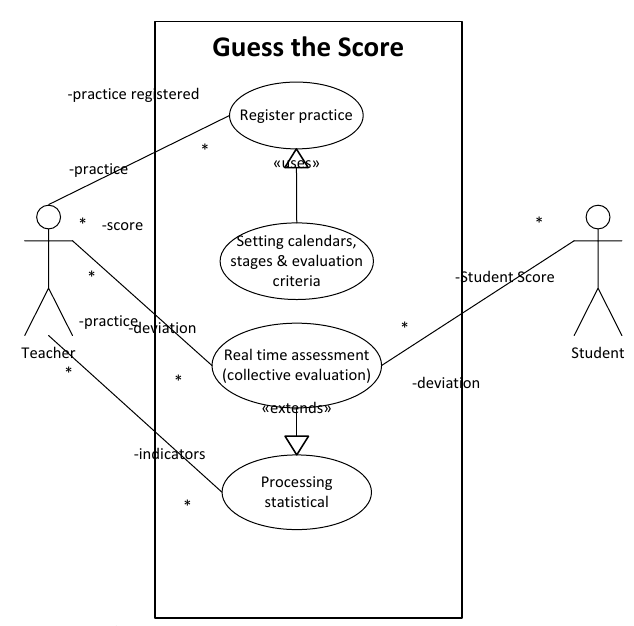
Figure 3 .Guess the score, context's use